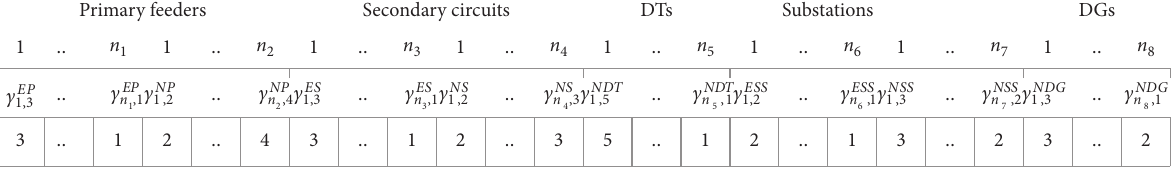
Figure 1: Codification scheme for the integrated DSP problem considering